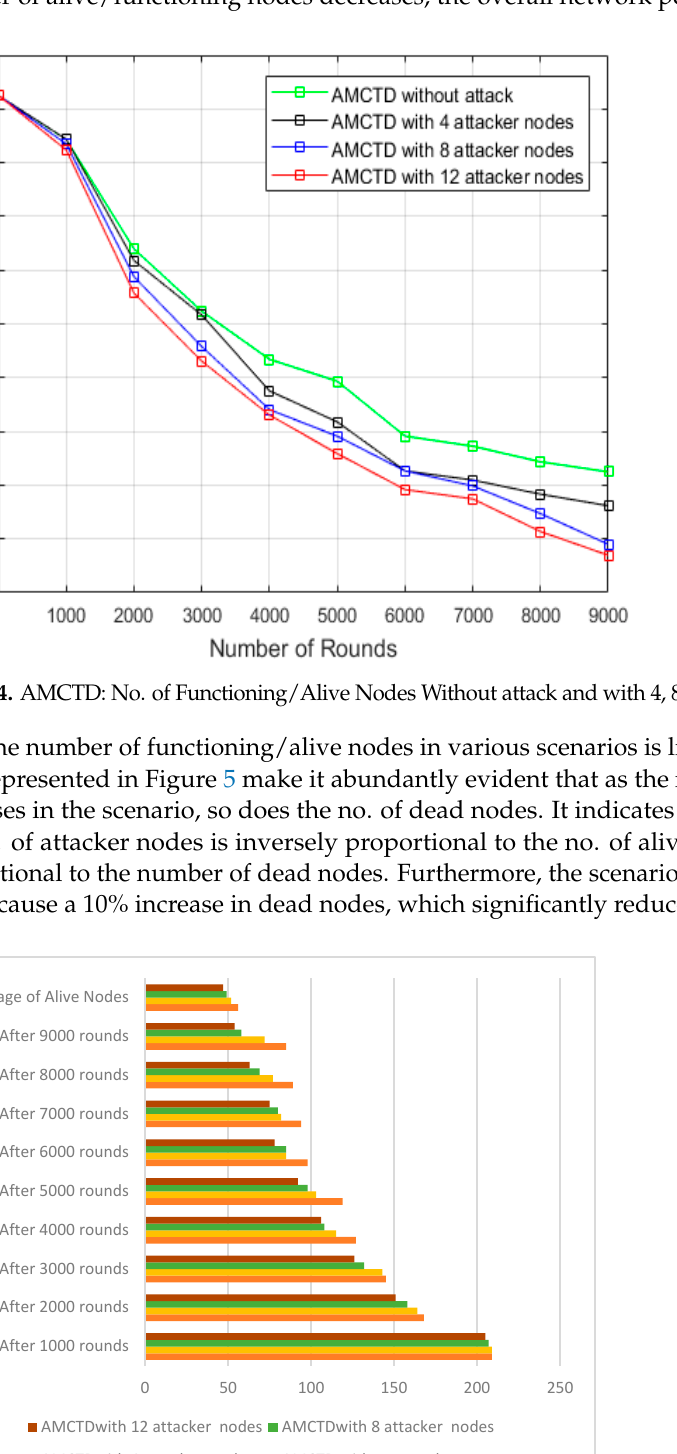
Figure 5. No. of Alive/Functional Nodes of AMCTD without Attack, AMCTD with 4, 8 and 12 At- tacker nodes.